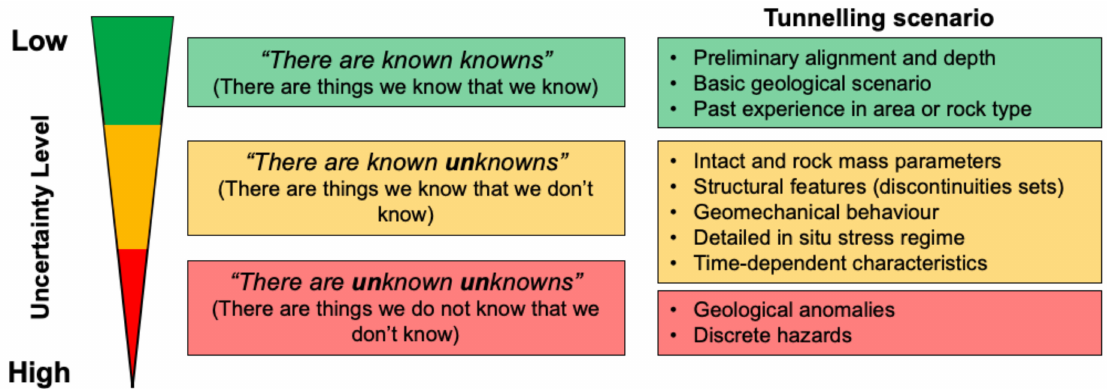
Figure 1. Design uncertainty in association with the geotechnical components (modified from [12]). Original quotes are from former US Secretary of Defence Donald H. Rumsfeld